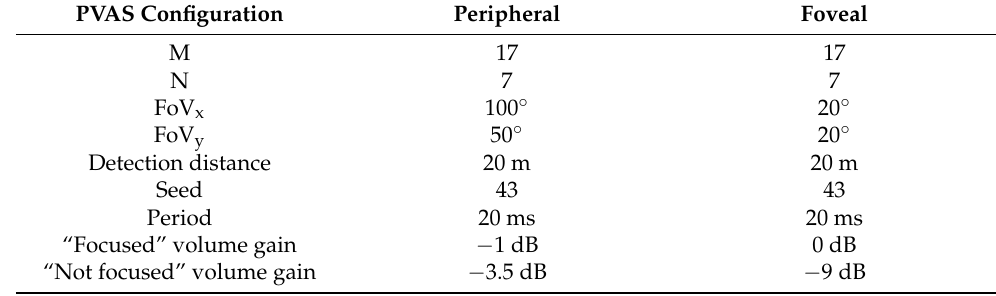
Table 3. VES-PVAS configuration of the third test. PVAS Configuration